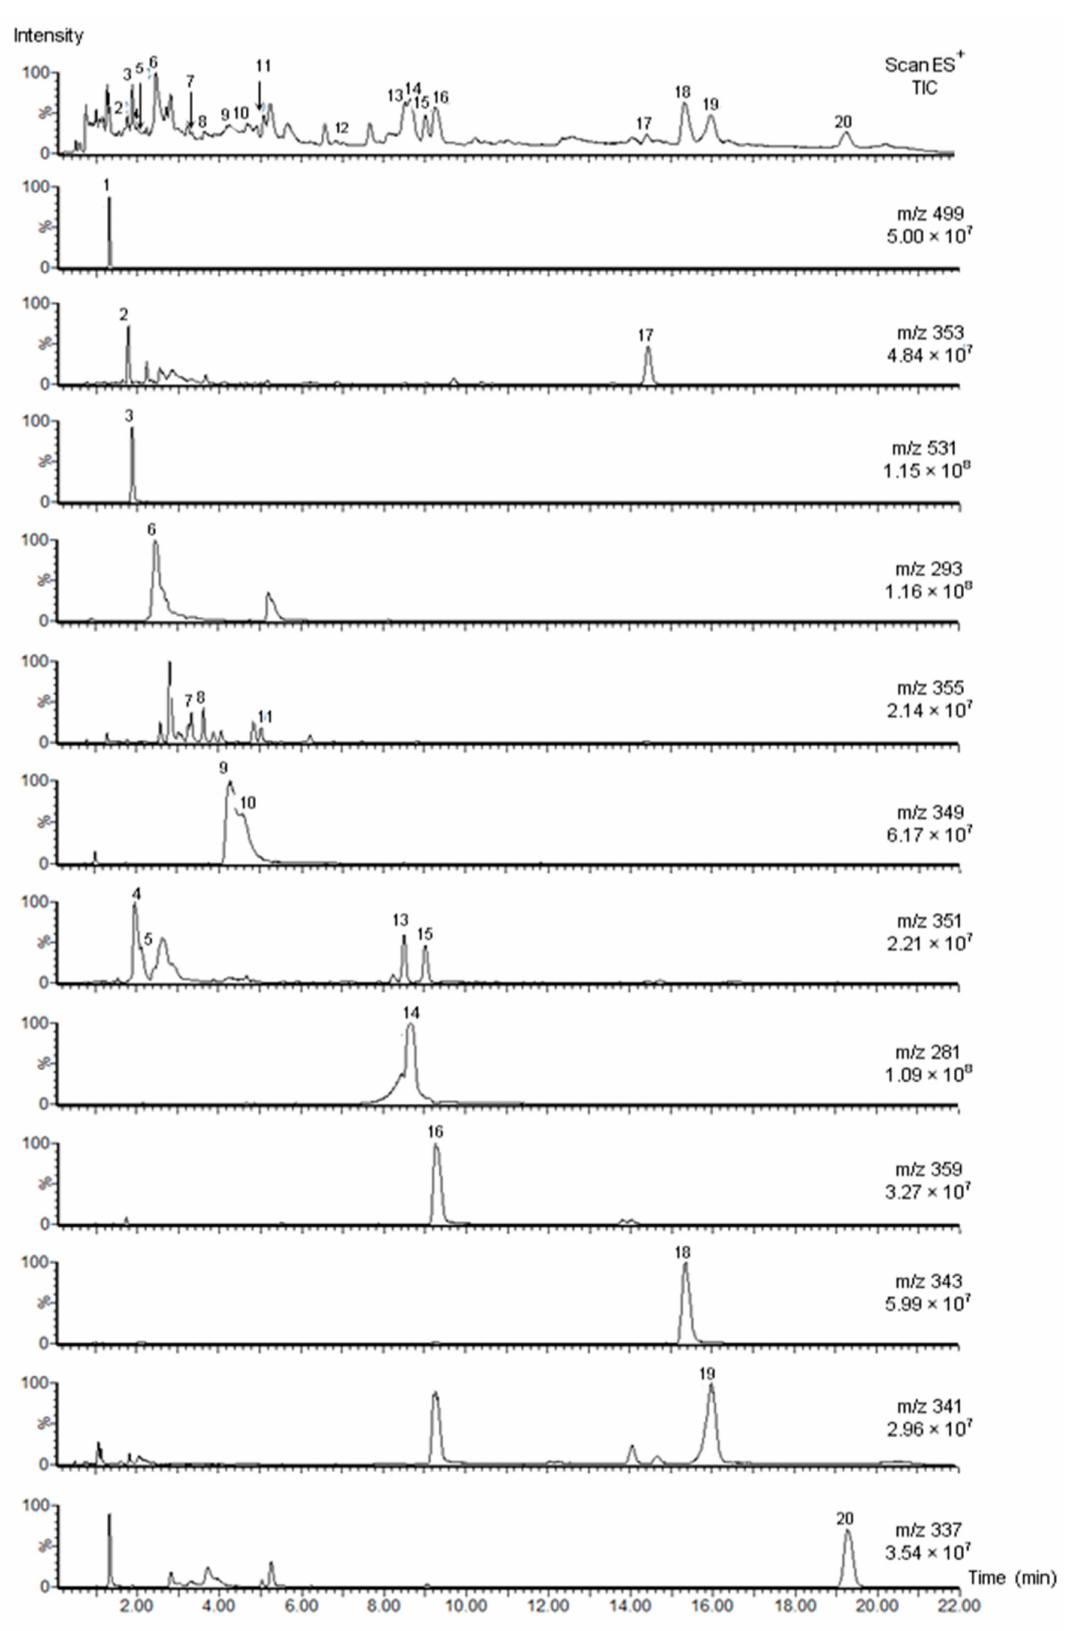
Figure 2. Extracted iongrams (ESI + ) of UPLC-PDA-MS-total ion current (TIC) analysis of R. stricta alkaloids. Data for vincadifformine ( 12 ) is presented in Figure S3.